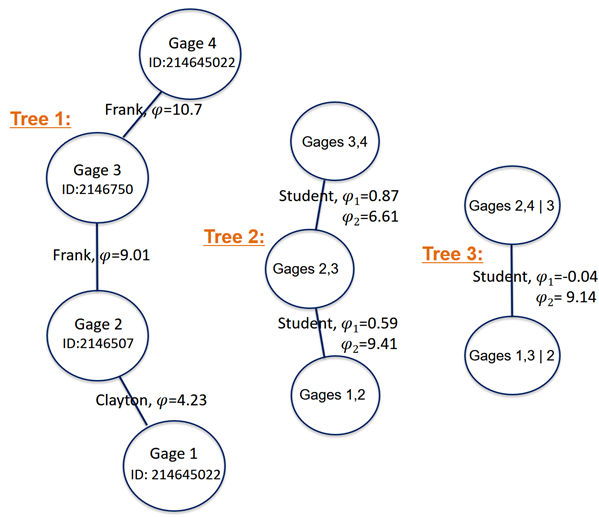
Figure 7. Structure of the Dvine copula applied for a particular tar- get site (USGS site ID 214645022), with the defined bivariate cop- ulas and their